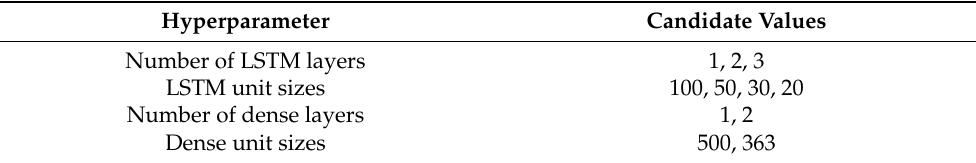
Table 2. Selected candidate values for hyperparameters of the LSTM model.